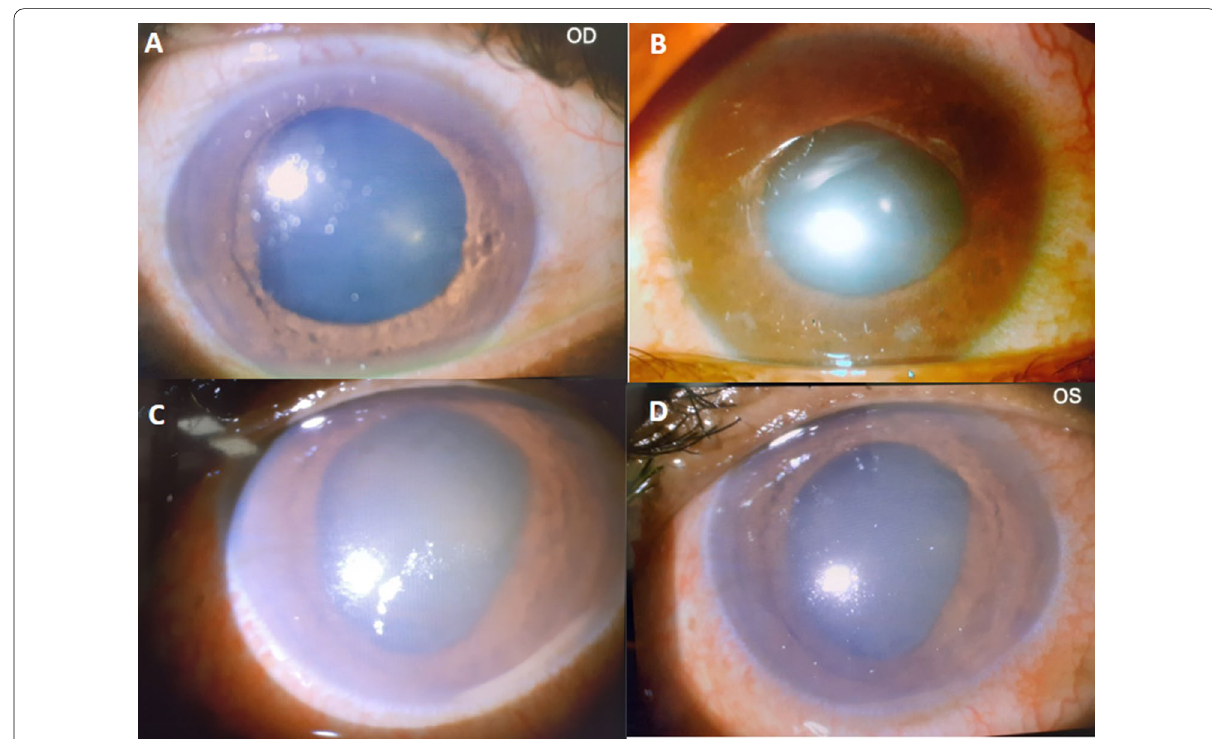
Fig. 1 Slit lamp image. A Before the treatment in Rt eye, mild corneal edema, shallow anterior chamber, mid dilated irregular fixed pupil with picking at 8 and 12 O’ clock position was observed. B After the treatment, the cornea is clear, the pupils are smaller than before the treatment, the response to light is slow, and the sphincter is atrophy at 12–2 o clock position. Right eye after treatment revealed clear cornea, constricted pupil than before treatment and sluggish reaction to light, sphincter atrophy 12–2 o clock position. C Left eye before treatment demonstrates. Severe diffuse corneal edema with shallow anterior chamber, irregular pupil and posterior synechiae from 2 to 6 O clock position. D Left eye after treatment showed improvement in corneal